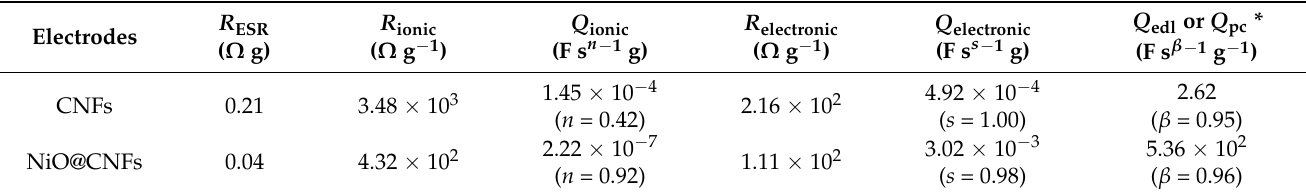
Table 2. Impedance parameters obtained from the CNLS simulation according to the effective macro homogeneous description of two closely mixed